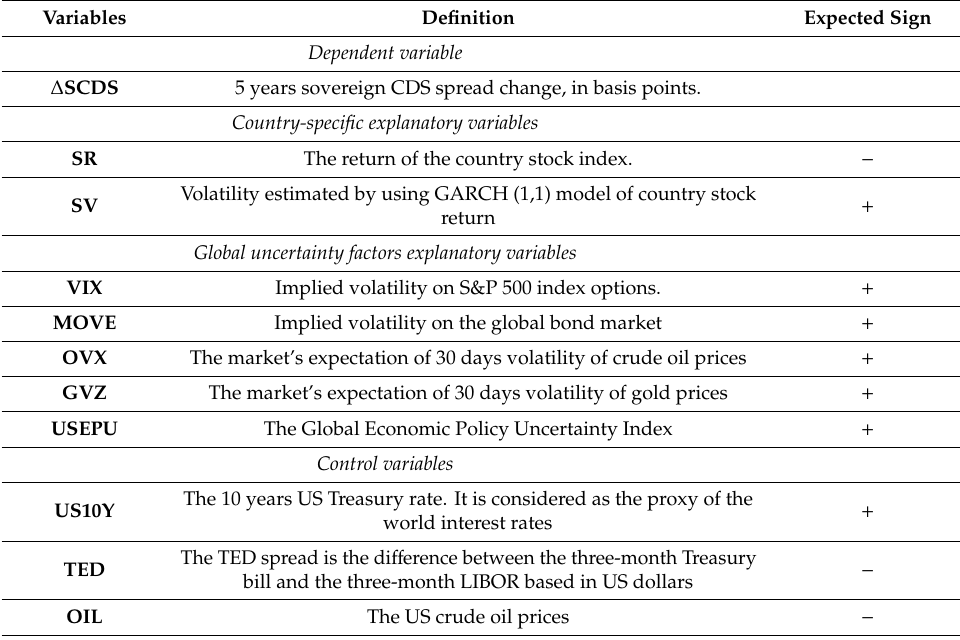
Table 1. Data description.